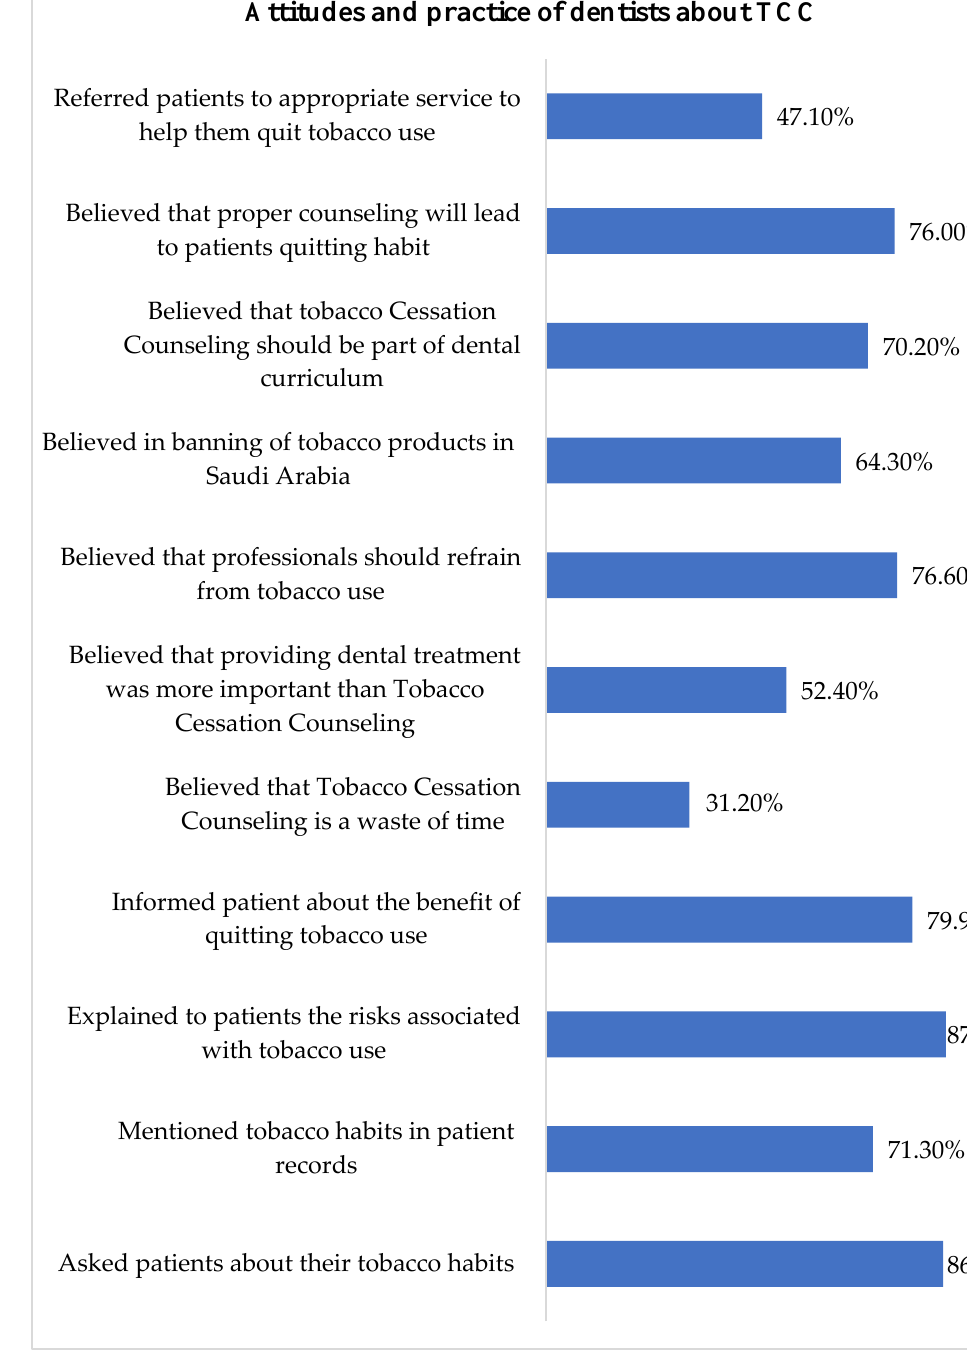
Figure 2. Distribution of dental profess ionals’ attitudes and behaviors about TCC.